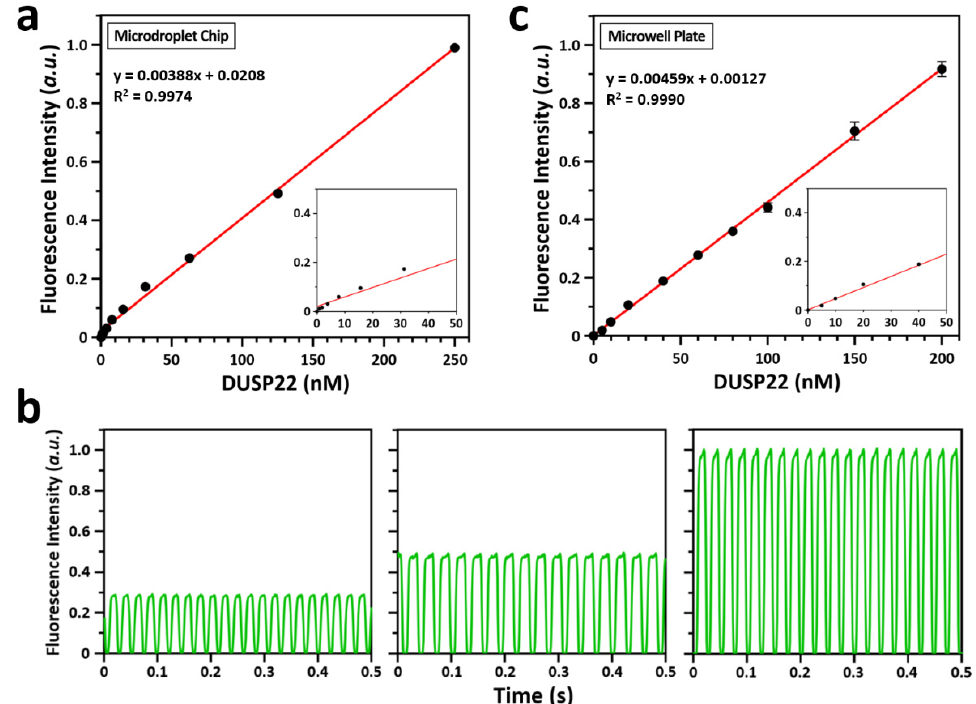
Figure 3. Fluorescence intensity analysis resulted from 3-OMFP degradation at designated concentrations of DUSP22. ( a ) Analysis of DUSP22 activity in a microdroplet chip. The concentration of 3-OMFP was fixed at 10 µM, and the concentration of DUSP22 was varied (0, 0.98, 1.95, 3.91, 7.81, 15.63, 31.25, 62.50, 125, and 250 nM). The error bars are smaller than the black circle of each concentration. Inset shows fluorescence intensity for DUSP22 below 50 nM. ( b ) Examples of fluorescence intensity scanned for 0.5 s from ~340.4 pL droplets generated within a microdroplet chip. From